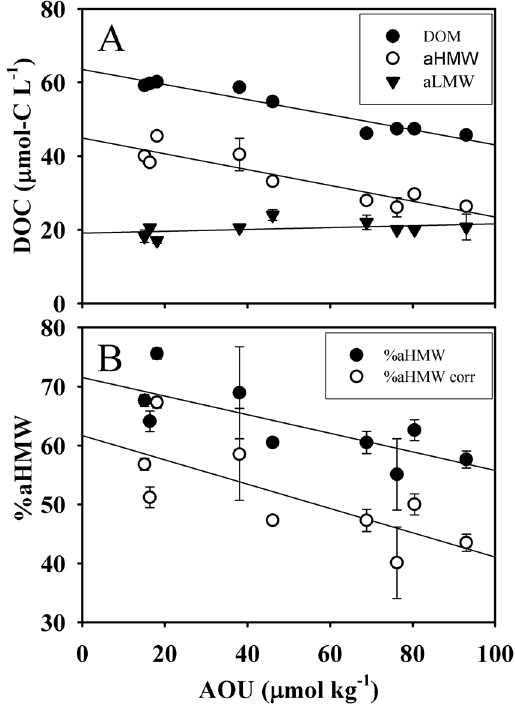
Figure 2. DOM size-fractionation with apparent oxygen utilization on a carbon basis. ( A ) size-fractionated DOC where DOM (solid black circles), aHMW (open circles) and aLMW (solid black triangles) represent the bulk DOC, the apparent high molecular weight fraction and the apparent low molecular weight fraction, respectively. ( B ) aHMW percentage (solid black circles) and corrected aHMW percentage (open circles) with respect to apparent oxygen utilization (AOU) of samples collected along the core-of-flow of the Levantine Intermediate Water. Error bars represent standard